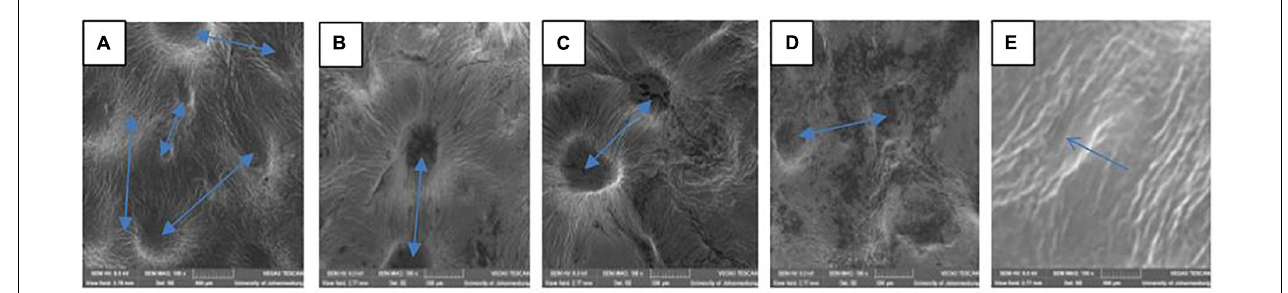
FIGURE 1 | Scanning electron microscopy (SEM MAG: 200 × ) of ‘Kinnow’ mandarin rinds coated with gum arabic coating fused with zinc oxide nanoparticles. (A–E) Correspond to cross-sectional morphology of control; gum arabic coating (2%); gum arabic + zinc oxide nanoparticles (0.25%); gum arabic + zinc oxide nanoparticles (0.5%) and gum arabic + zinc oxide nanoparticles (1%),